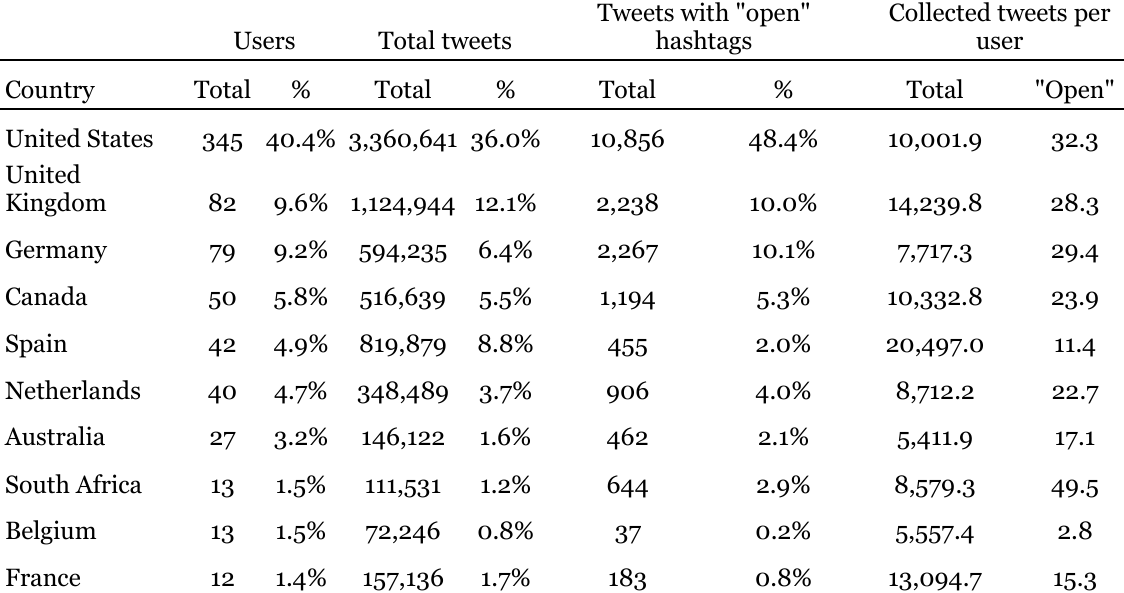
Top 10 Participating Countries by User Counts and